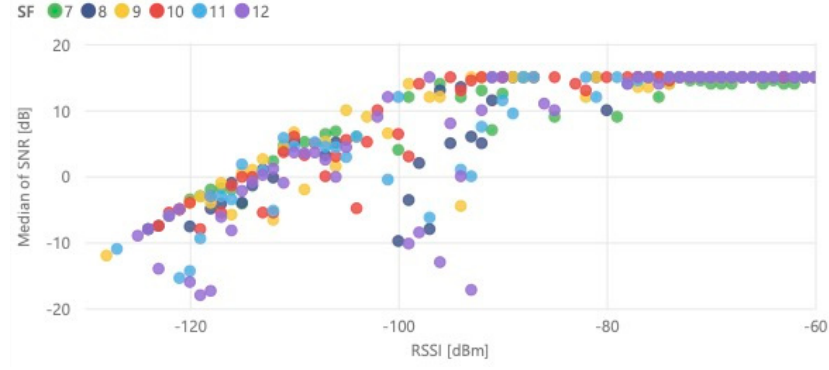
Figure 16. Received message SNR versus RSSI.